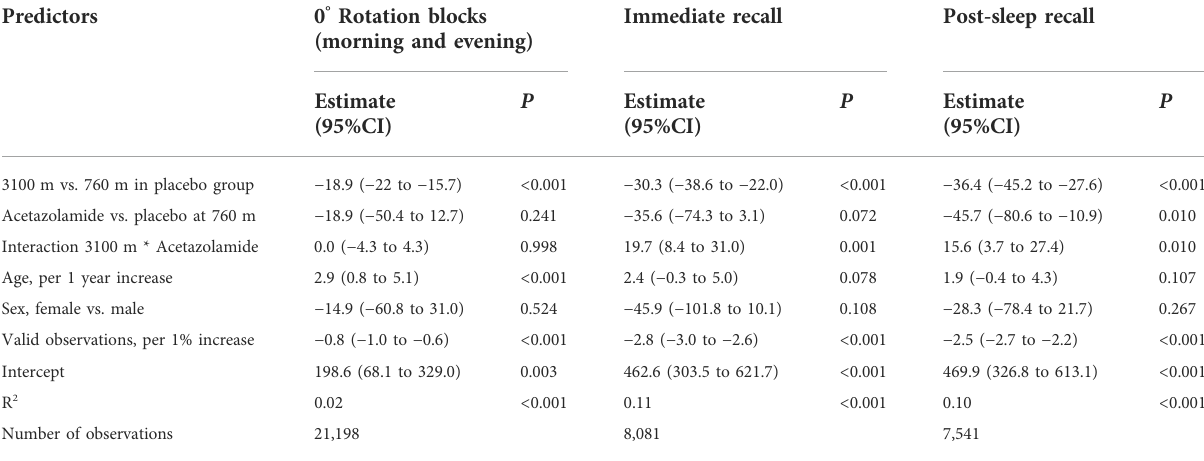
Paneldatamultivariatelinearregressionmodelwithpatientnumberde fi nedaspanelvariableandmovementnumberastimevariable;CIdenotescon fi denceinterval.Altitude,druggroup and sex are binary variables. A negative value indicates an improvement of reaction